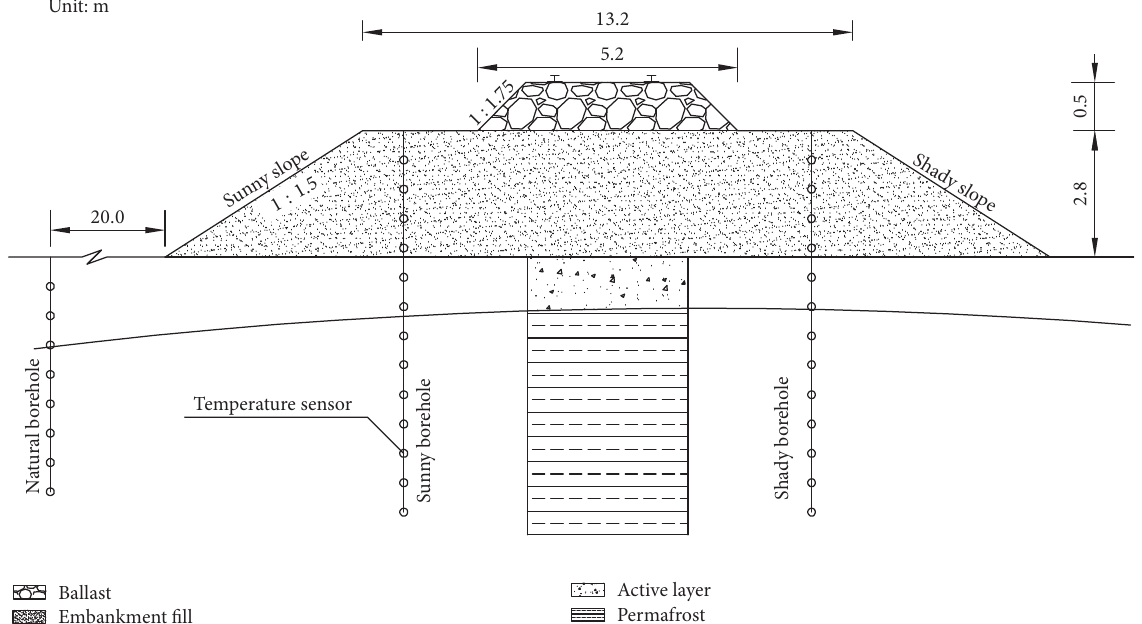
Figure 3: Monitoring system for the ground temperature at section K1068+750.